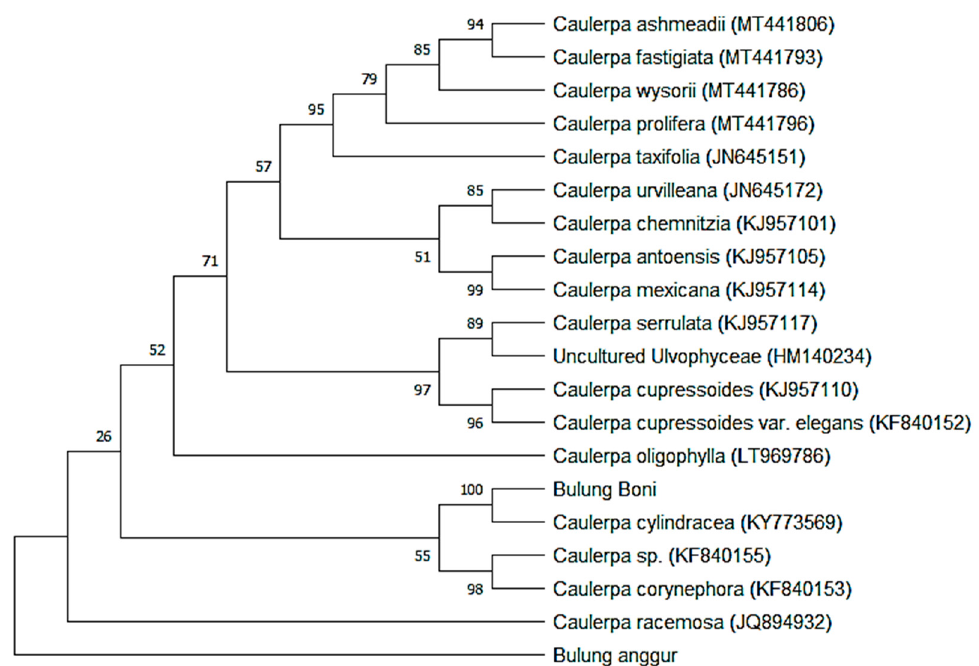
Figure 5. Phylogenetic tree for Bulung Boni and Bulung Anggur based on tuf A sequences, constructed with maximum likelihood.